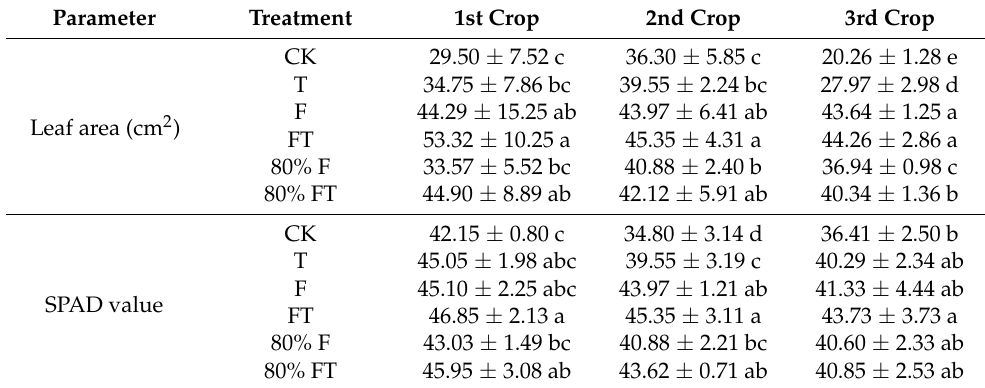
Table 2. Effect of the preparation on pakchoi leaf area and SPAD